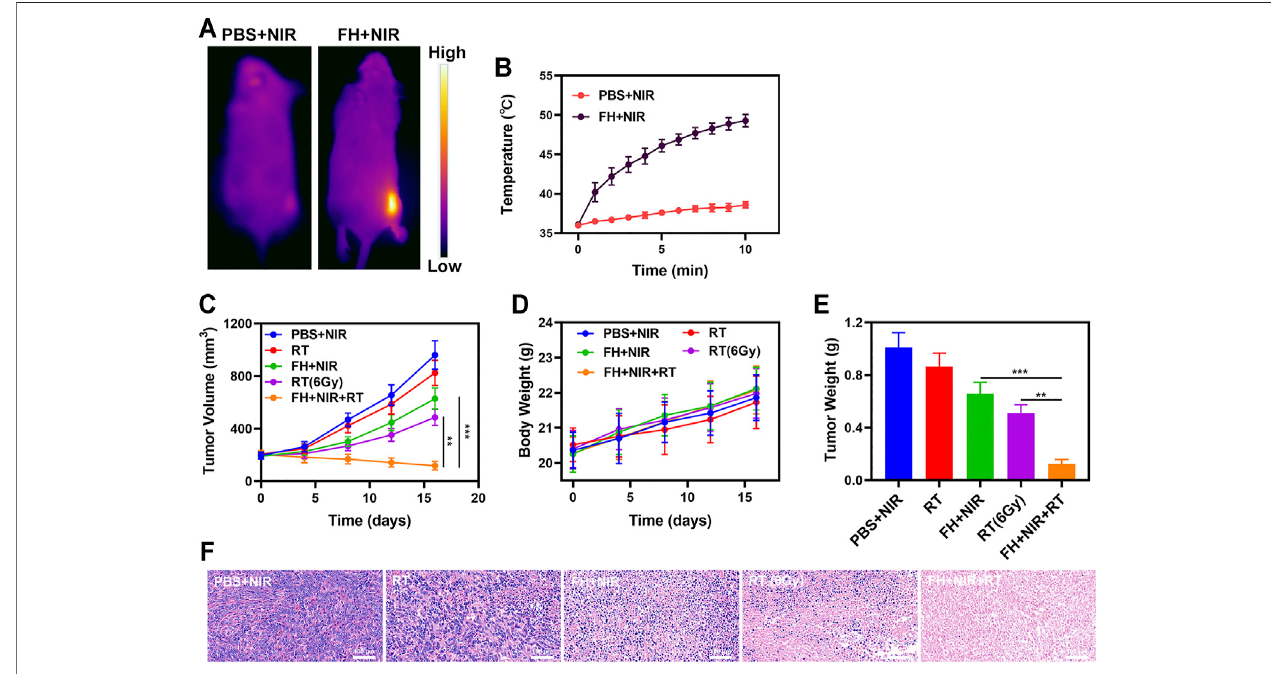
FIGURE 3 | (A) IR thermal images of tumors following an 808 nm laser irradiation (0.5 W/cm 2 ) for 5 min in the indicated treatment groups. (B) Temperature increases in mice implanted with 4T1 tumors following 808 nm laser irradiation (0.5 W/cm 2 ) for 5 min in the indicated treatment groups. (C) Tumor volume change over time in groups treated as indicated. (D) Changes in body weight in response to the indicated treatments. (E) Average tumor weight values associated with the indicated treatments. (F) H and E stained tumor sections from the indicated treatment groups. ** p < 0.01, *** p < 0.005; Student ’ s t -test.